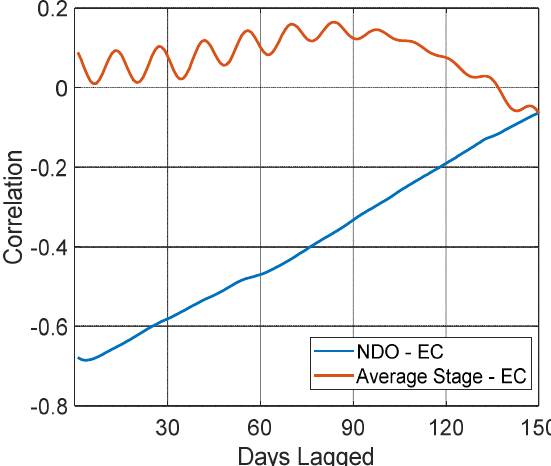
Figure A2. Correlation between daily Martinez salinity and lagged Martinez stage as well as net Delta outflow.